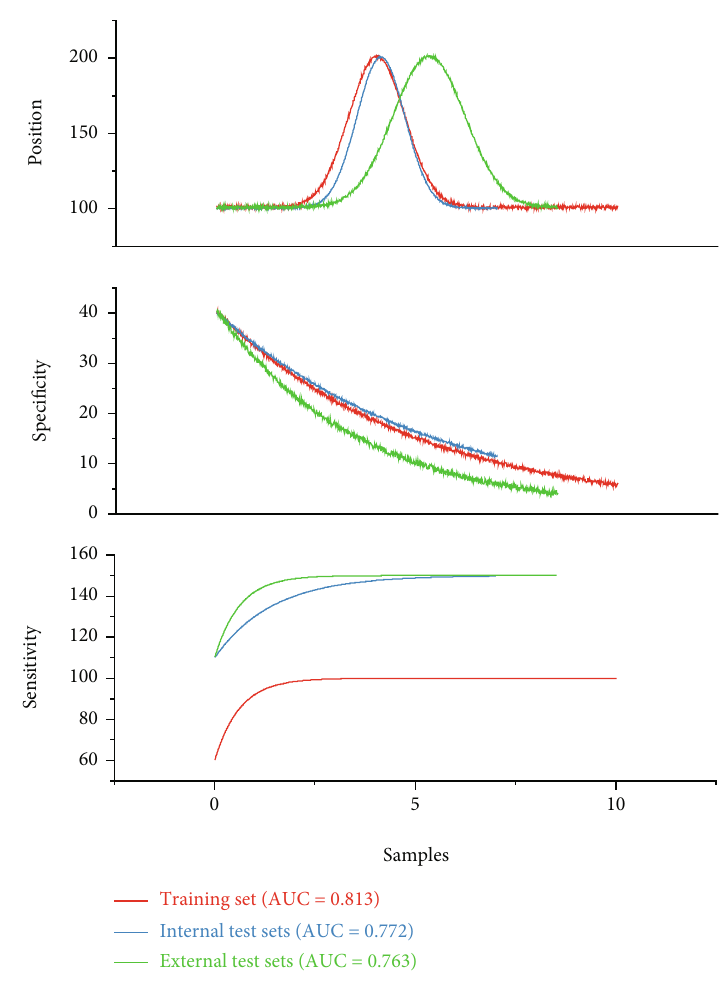
Figure 3: AUC values of the mildly mixed model compared with the mixed